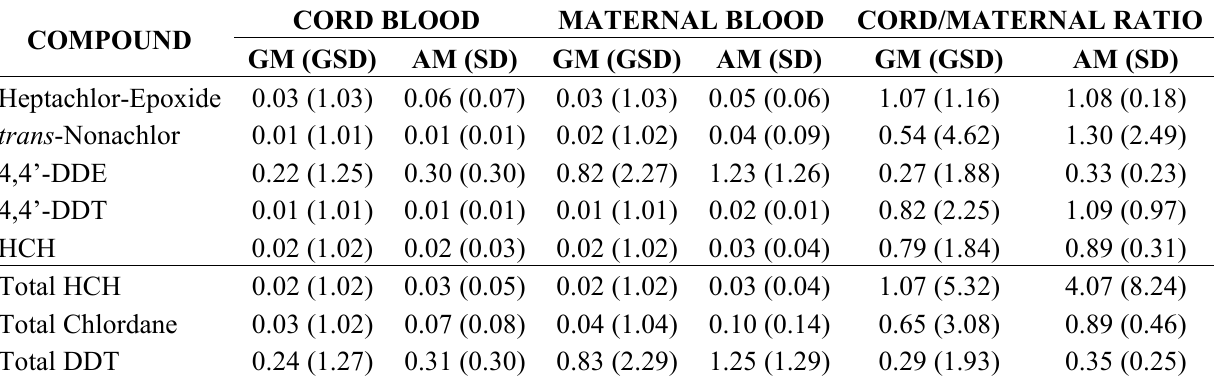
Table 3. Summary statistics for OC concentrations (ng/mL) in matched pairs of maternal and cord blood (N =